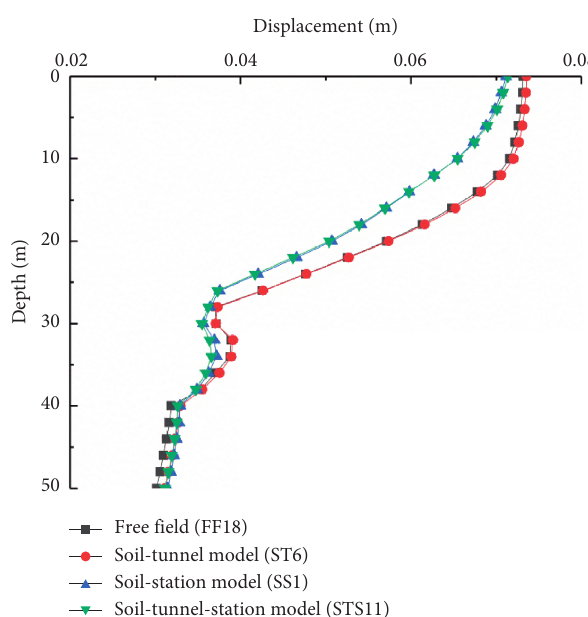
Figure 9: Soil displacement in the depth direction under El-Centro wave.